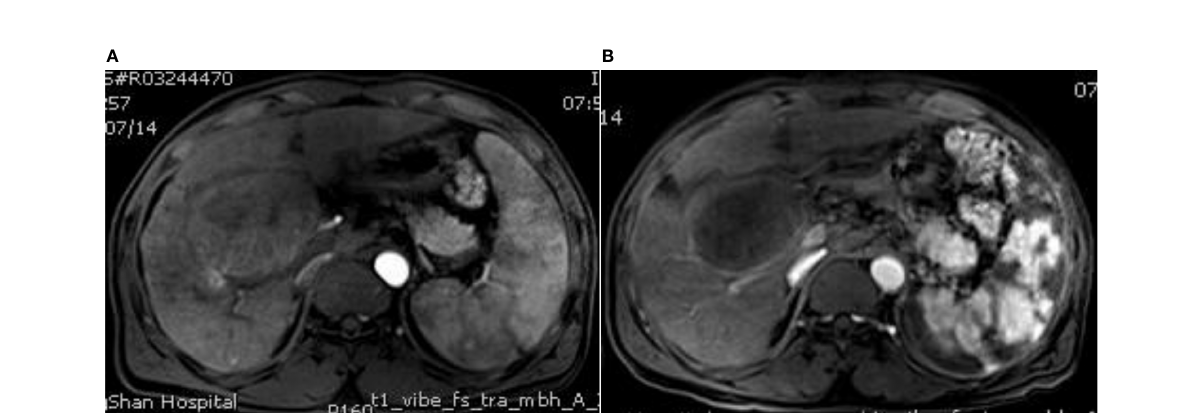
FIGURE 2 MRI image before surgery and MRI image after surgery. (A) The contrast-enhanced MRI of the liver shows multiple space-occupying lesions, the larger lesions are located in the right lobe of the liver, which adjacent to the hepatic hilum, moderate enhancement and splenic enlargement can be observed in the arterial phase; (B) Enhanced MRI of the upper abdomen at 3 months after surgery showes that the liver tumor shrank without obvious enhancement, the spleen shows piebald necrosis, the spleen infarct area accounts for about 50%, and the platelets and leukocytes increase to the normal level and are stable.